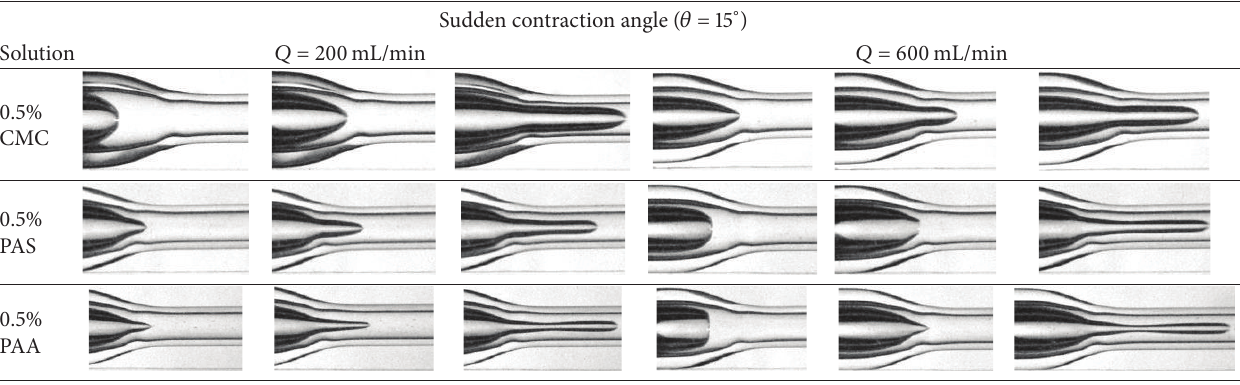
Table 3: Evolution of bubble contours for sudden contraction angle 𝜃 = 15 ∘ .